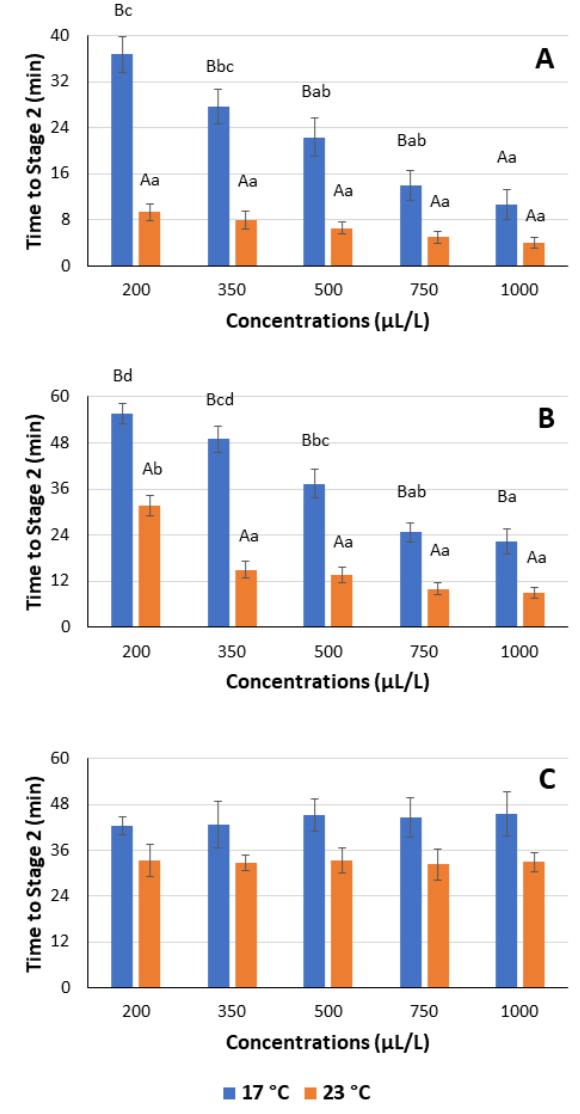
Figure 1. Times to Stage 2 induction (min) for three different plant-based essential oils used as a natural anesthetic for red swamp crayfish. (A) Clove oil (in two-way ANOVA, p = 0.0000 for concentration, p = 0.0000 for temperature, and p = 0.0012 in interaction); (B) spearmint oil (in two-way ANOVA, p = 0.0000 for concentration, p = 0.0000 for temperature, and p = 0.0063 in interaction); (C) chamomile oil (in two-way ANOVA, p = 0.9901 for concentration, p = 0.0004 for temperature, and p = 0.9896 in interaction). Different uppercase letters indicate significant differences between temperatures at the same concentration. Different lowercase letters indicate significant differences between concentrations at the same temperature ( p <